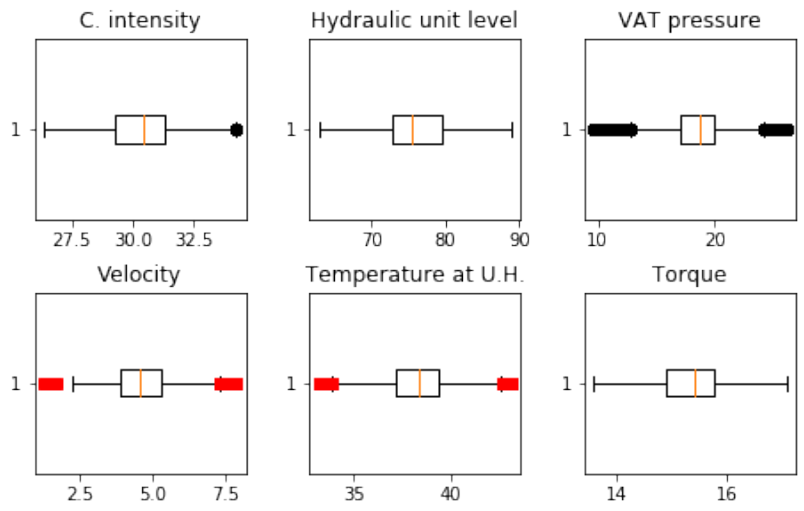
Figure 4. Distribution of data points of all the sensors, with lowly and highly discrepant data